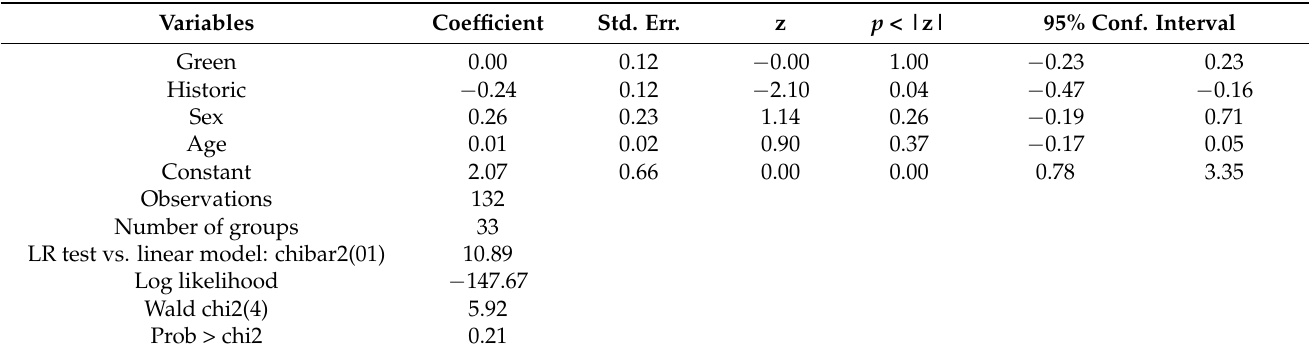
Table 7. Stress (Information Criterion 318).